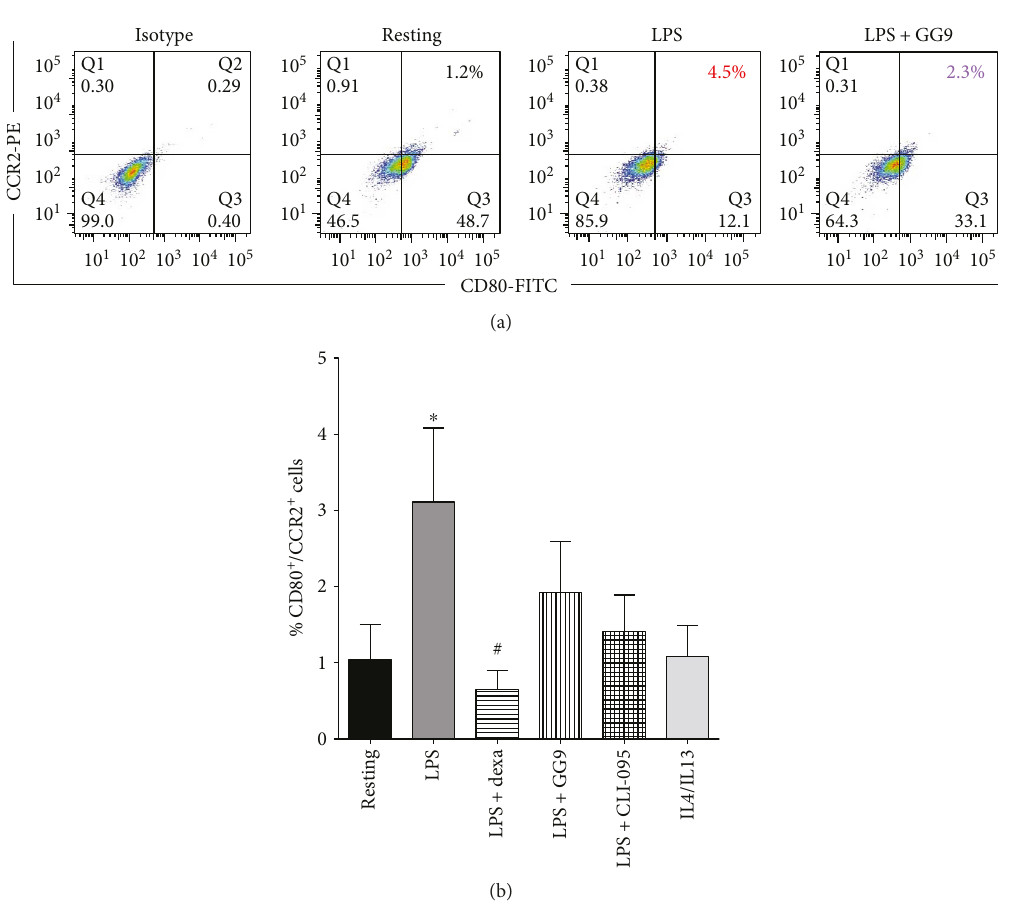
Figure 2: E ff ects of GG9, dexamethasone (dexa), and CLI-095 on the M1 macrophage phenotype as de fi ned by CD80 + /CCR2 + cells. Cells were activated and treated as described in the legend of Figure 1. Fluorescence quanti fi cation dot plots (a) are from a representative experiment. Bars represent the mean ( ± SEM) of CD80 + /CCR2 + cells (b) from 6 independent experiments. ∗ p < 0 05 versus resting; # p < 0 05 versus